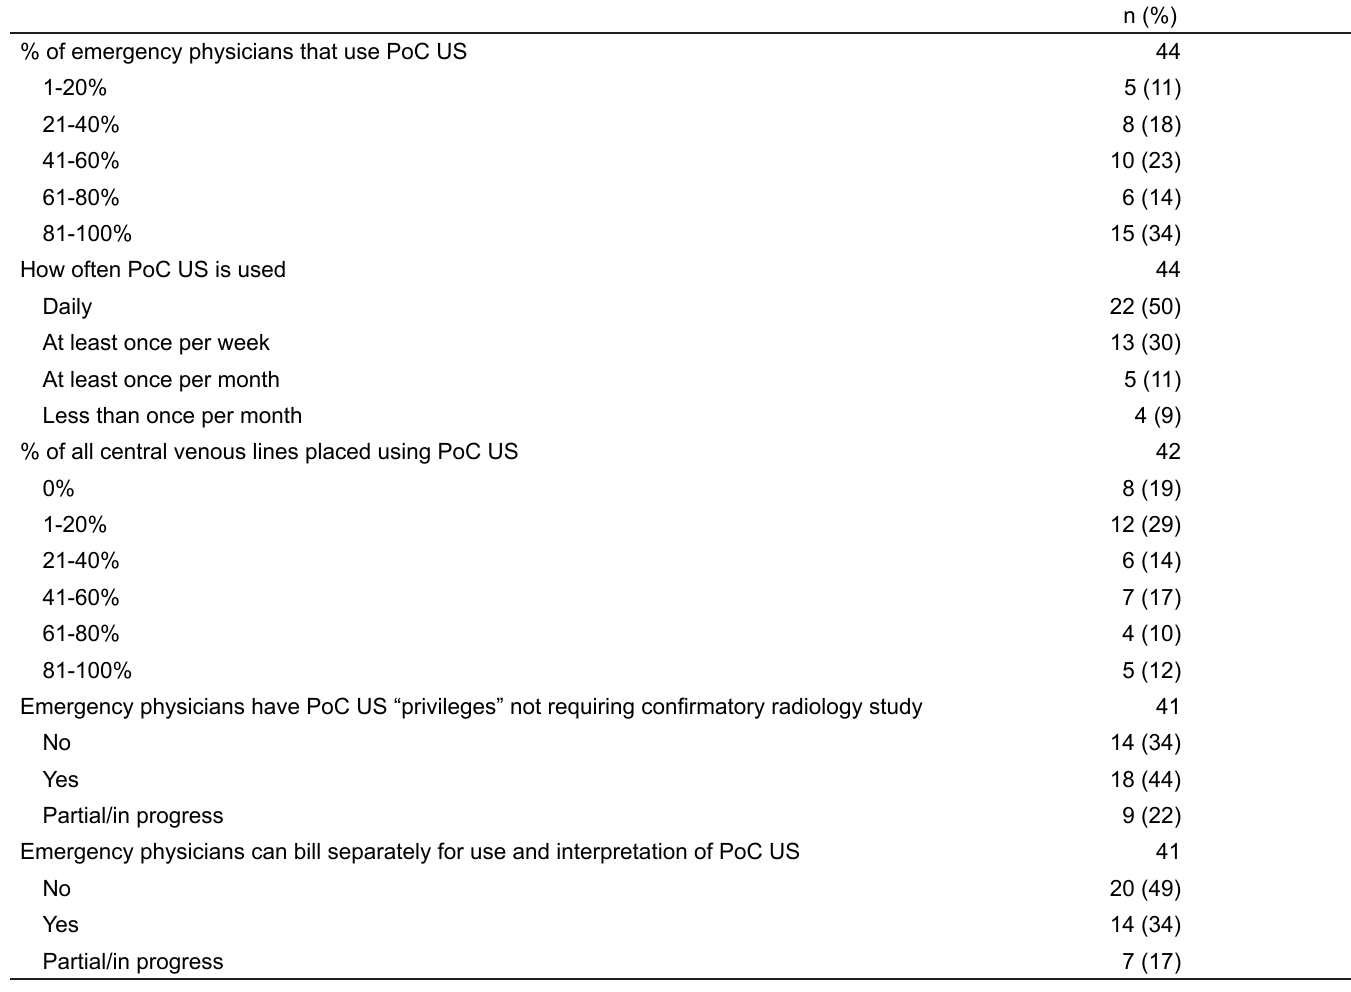
Table 3. Use patterns of point-of-care ultrasound (PoC US) in four states (n=123 emergency